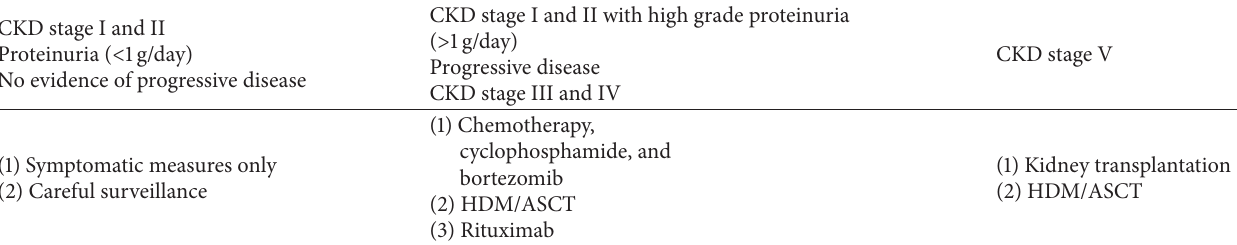
Table 2: Treatment recommendation for PGNMID